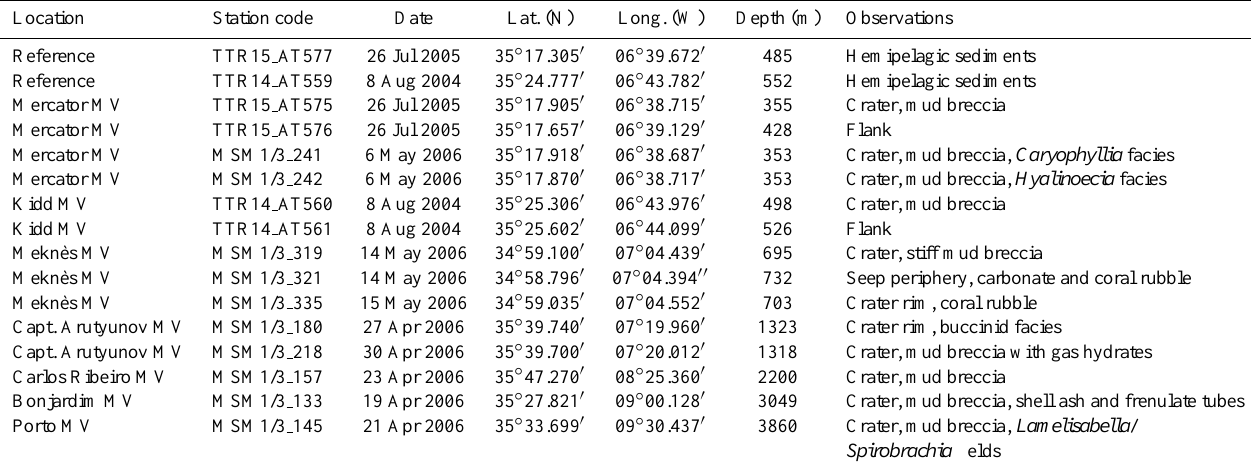
Table 1. Metadata for the sampling stations in the Gulf of Cadiz. Station code: the label is composed of the cruise name and station number as used in Pangaea database (www.pangaea.de ); for simplification in figures and text the stations are referred to only by the three last